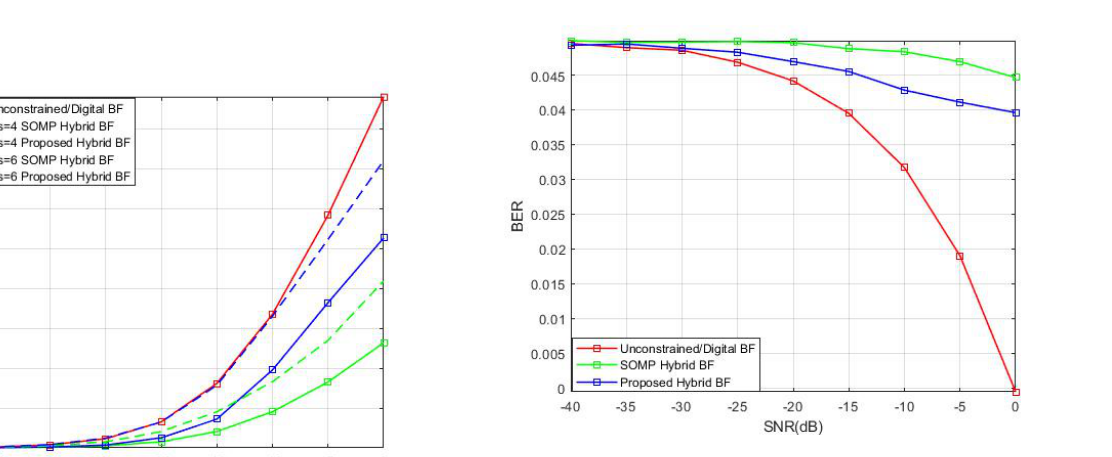
Fig. 10. Radiation response of HBF